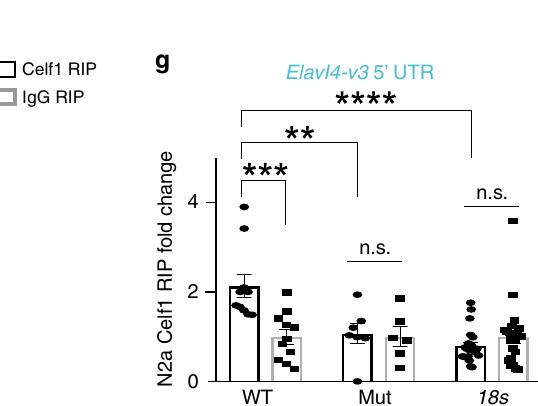
monosome, and light polysome fractions relative to control (Ctrl) shRNA (Fig. 5a). Elavl4-v2 did not shift signi fi cantly (Fig. 5b) and again Elavl4-v3 unreliably ampli fi ed. This aligns with increased translation of Ren via the Elavl4-v1&4 5 ′ UTR in Celf1 knockdown (Fig. 5c). In addition, we found increased translation of Ren via the Elavl4-v3 5 ′ UTRs in Celf1 knockdown (Fig. 5c). Silencing Celf1 in N2a cells elevated steady-state levels of